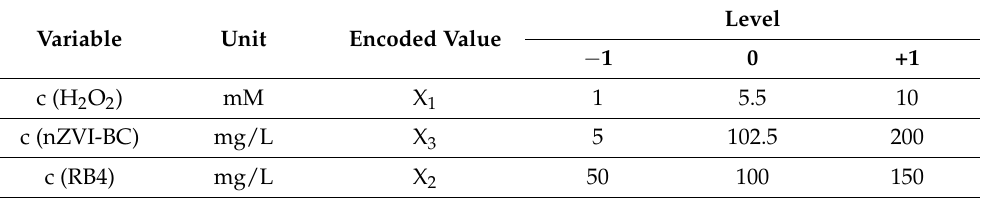
Table 8. The experimental levels of the three process parameters. Variable